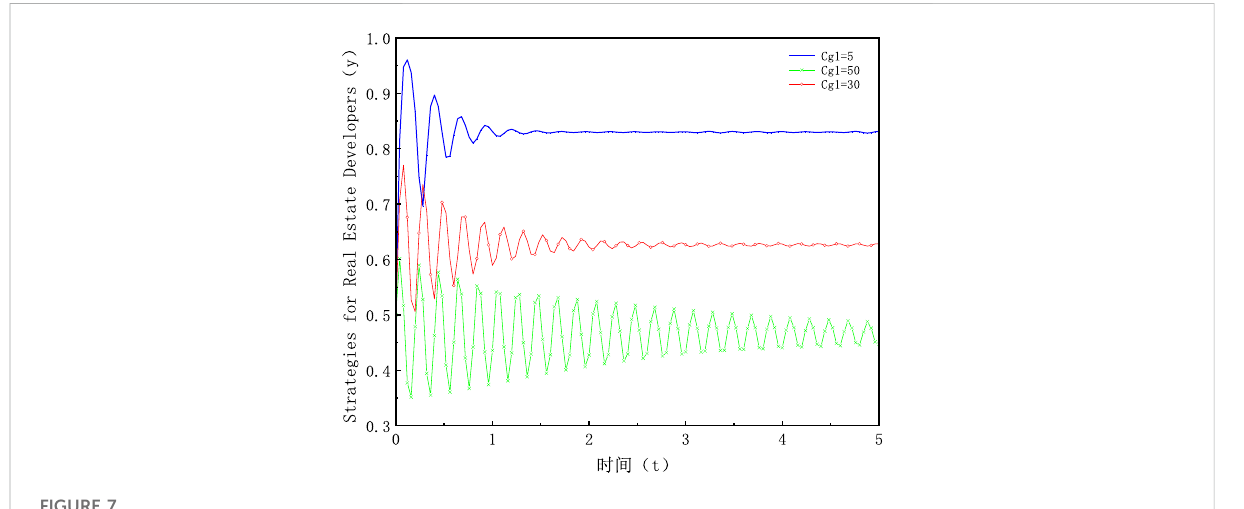
FIGURE 7 Strategies evolution of property developers under different Cg1.